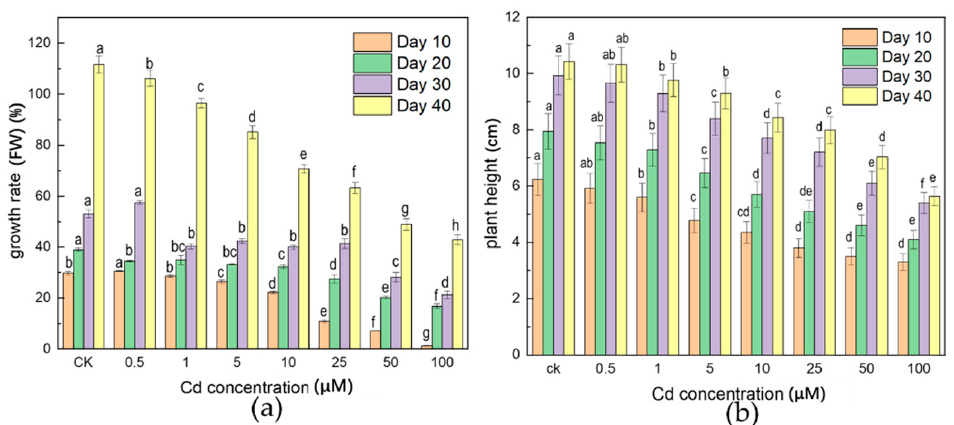
Figure 1. The effect of different concentrations of Cd on the growth rate (FW) and plant height of A. selengensis . ( a ) growth rate (FW), ( b ) plant height. The results are means ± SD ( n = 3), lower letters mean significant differences ( p < 0.05) between different Cd concentrations at the same